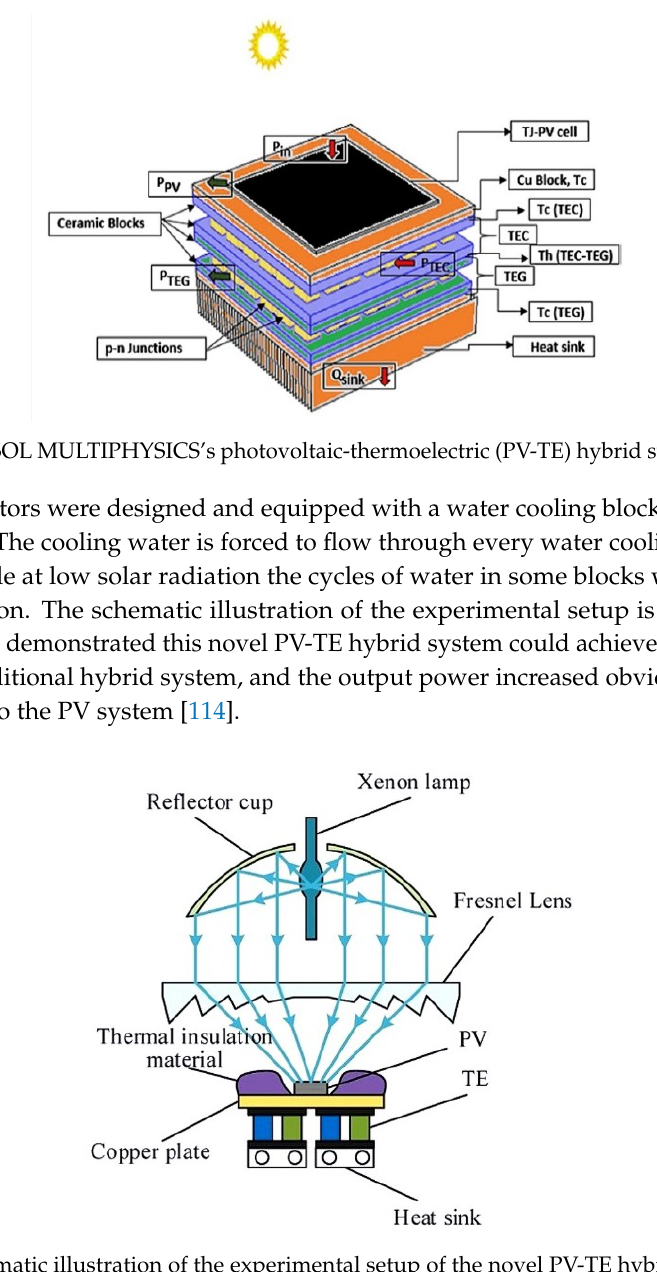
Figure 27. Schematic diagram of the cross-section of CPV/T+TE hybrid collector [115]. Table 6 summaries the cogeneration power technologies mentioned above.